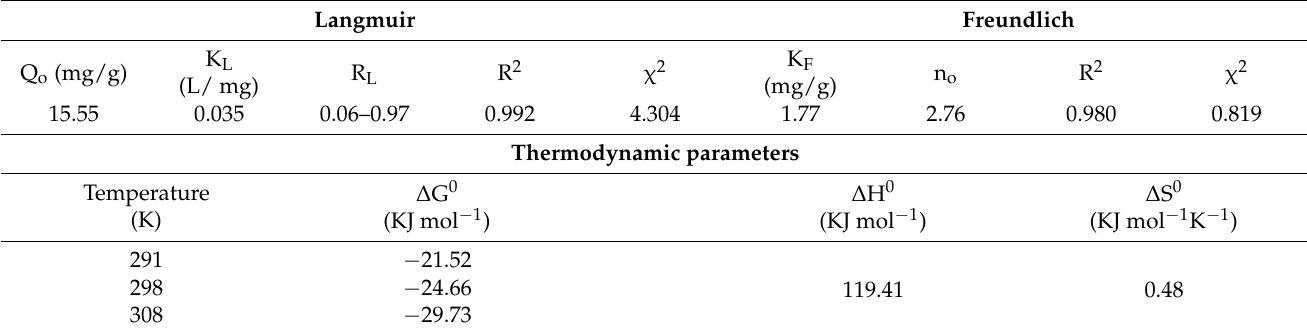
Table 3. Isotherm parameters obtained by linear methods for adsorption of Pb(II) onto ZnO/CA and thermodynamics parameters. Langmuir Freundlich